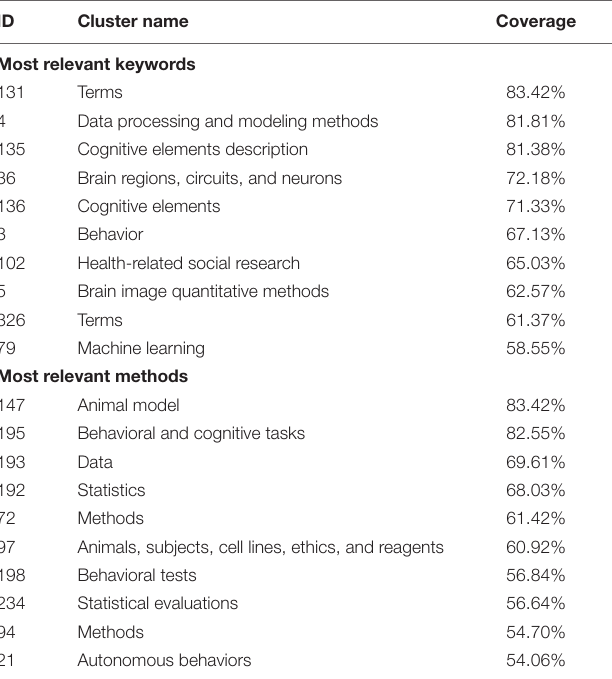
TABLE 3 | Difference in coverage between clusters of keywords and methods on articles in cluster